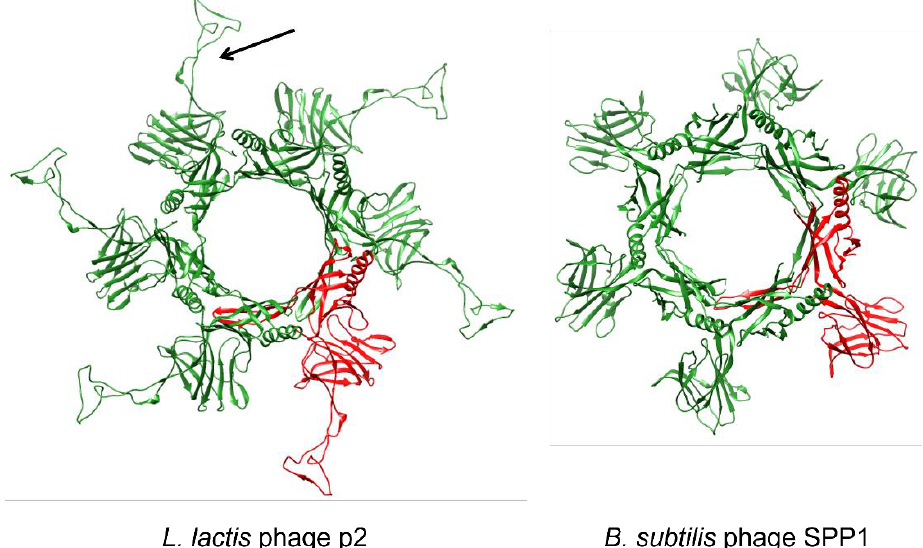
Figure 5. Structure of Dit proteins of L. lactis phage p2 (left) and B. subtilis phage SPP1 (right). Dit proteins form hexameric structures, and one monomer is highlighted in red. In p2 Dit protein, the “arm” structure is indicated by an arrow. Structures were retrieved from the Protein Data Bank (p2 Dit: PDB ID 4V5I and [119]; SPP1 Dit: PDB ID 2X8K and [118]).